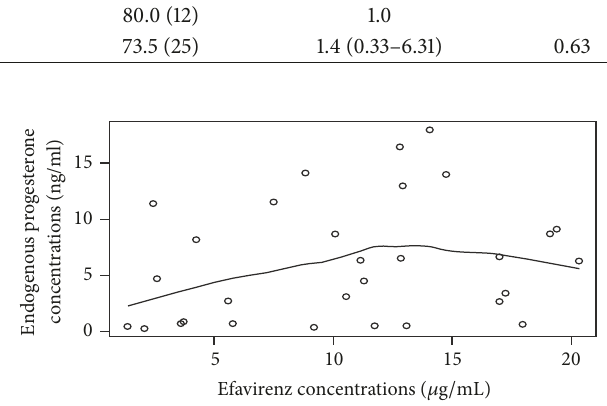
Table 2: Contraceptive outcomes among HIV positive women taking combined oral contraceptive pills at TASO Clinic, Mulago Hospital. HAART naive HIV positive women